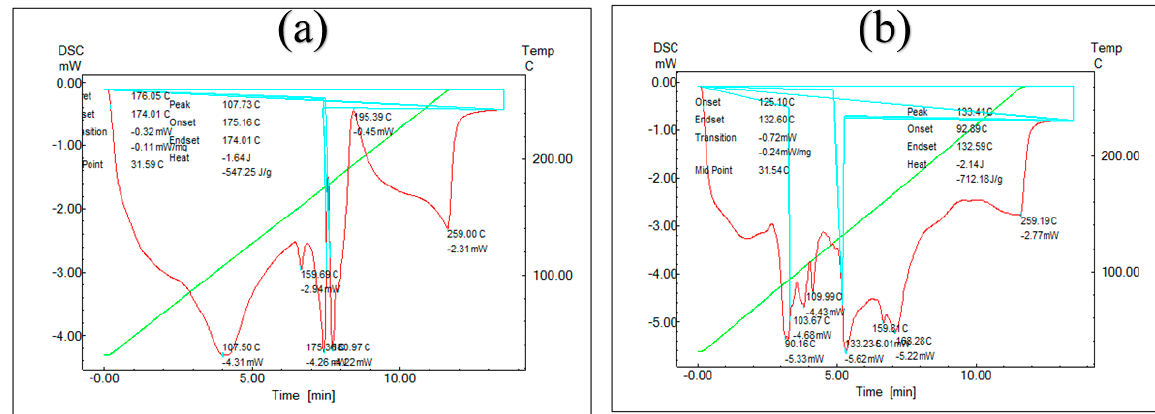
Figure 5. ( a ) DSC analysis of doxorubicin and ( b ) optimized formulation.